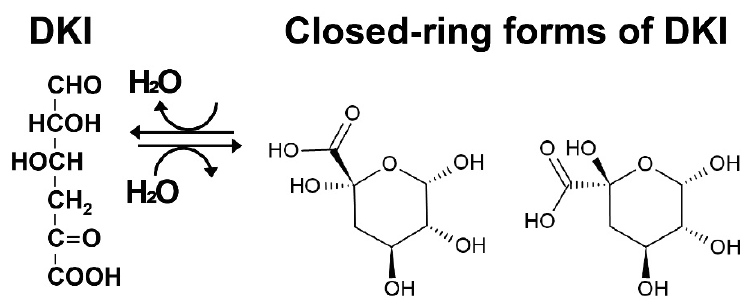
Figure 2. Closed-ring forms of DKI. 4-Deoxy-5-hydroxy- α - D -glucopyranuronate ( left ) and 4-deoxy- 5-hydroxy- α - D -idopyranuronate ( right ) [6].